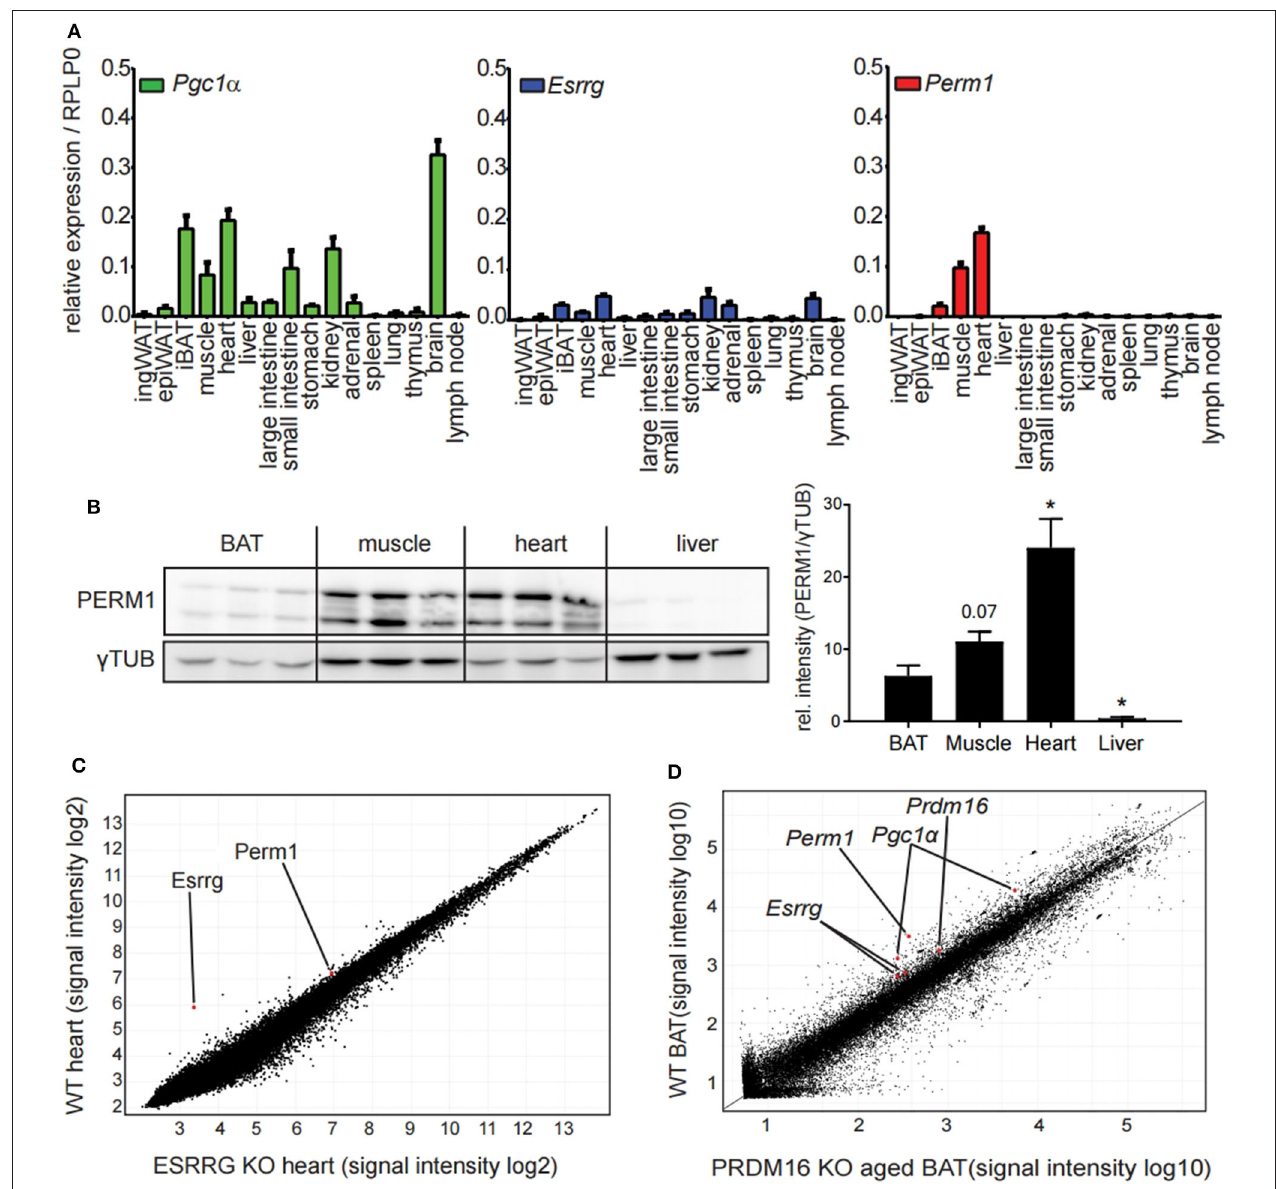
FIGURE 3 | PERM1 expression is confined to tissues with a high energy demand and with ESRRG involved in energy metabolism. (A) Expression of Perm1 , Esrrg, and Pgc1 α in a panel of 16 tissues derived from C57BL/6 mice housed at room temperature. Data are shown as relative expression to reference gene RPLP0 with SEM ( n = 5). (B) Representative western blot and quantification of PERM1 in BAT, muscle, heart, and liver. Each lane represents a single mouse ( n = 3). (C) Microarray analysis of RNA extracted from heart tissue of ESRRG knockout mice as described in (29). Data were retrieved from GSE8199, plotted are all transcripts as log2 signal intensities ( n = 3). (D) Representative microarray analysis of RNA extracted from BAT of aged mice, where PRDM16 is knocked out under the control of MYF5 promoter, leading to a whitening of BAT, as described in (31). Data were retrieved from GSE55080, depicted is one representative microarray